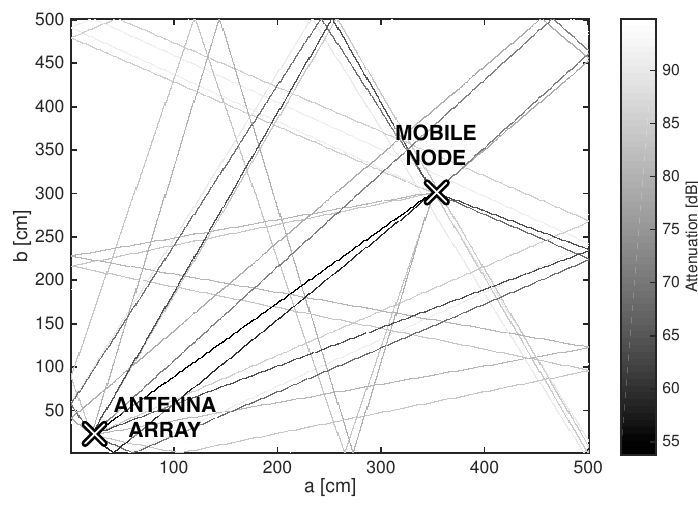
Figure 5. Simulated rays in a room of 5 m by 5 m with brick